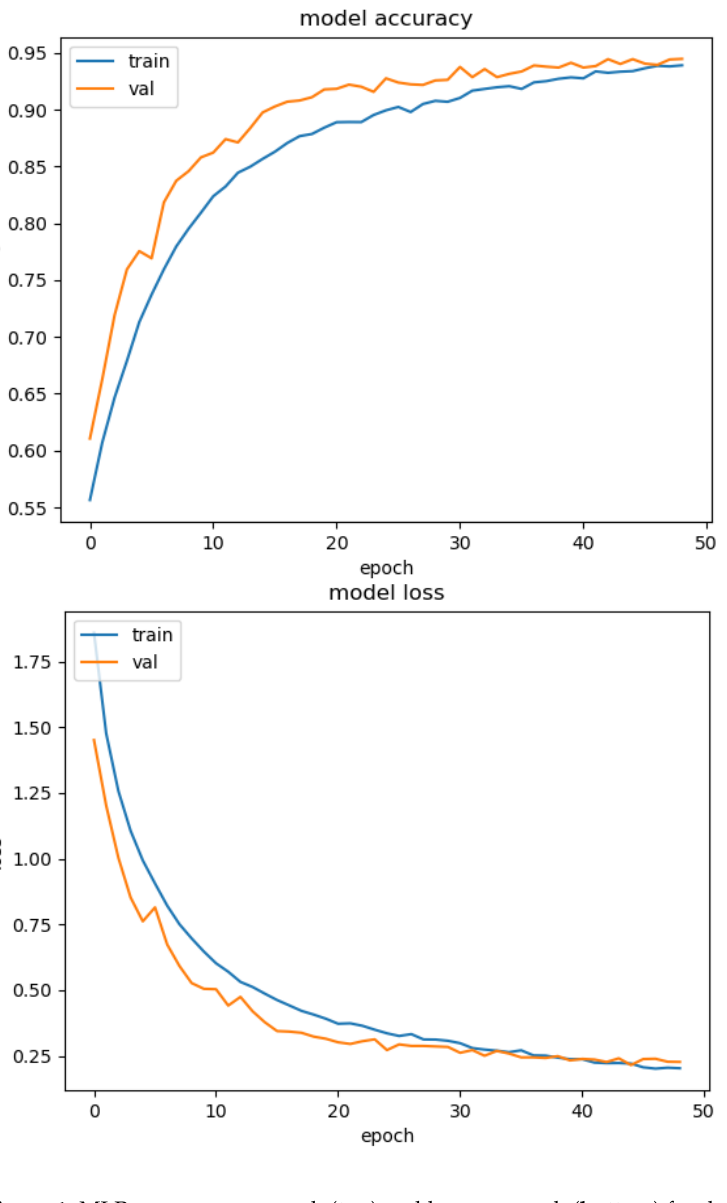
Figure 1. MLP accuracy per epoch ( top ) and lost per epoch ( bottom ) for the 1st fold training